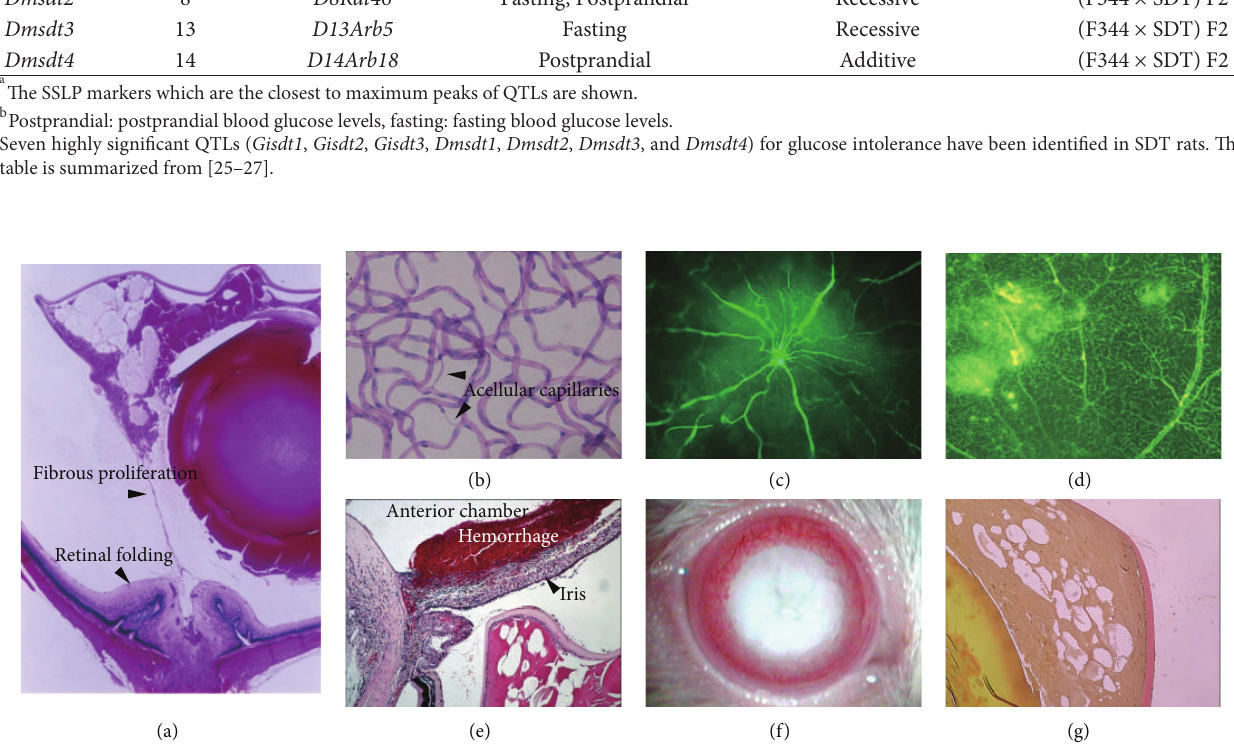
F 5: Diabetic ocular complications in SDT rats. Large retinal folds are seen in the midperipheral retina and around the optic disk. A tractional retinal detachment is observed with �brous proliferation (a) (HE stain). Retinal trypsin digestion shows acellular capillaries (b) (HE stain). Tortuous vessels and extensive �uorescein leakages are observed in retinal �at mounts from SDT rats (c, d). �assive hemorrhage in the anterior chamber associated with proliferation around the iris is seen in some severe case (e) (HE stain). e mature cataract is observed